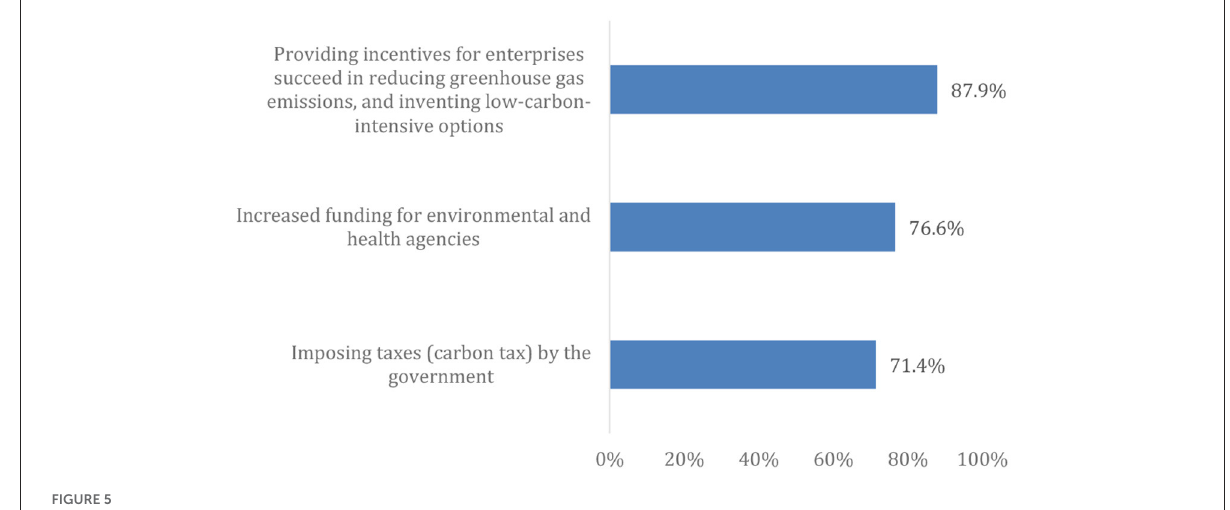
FIGURE5 Positive attitude toward mitigation measures to reduce global